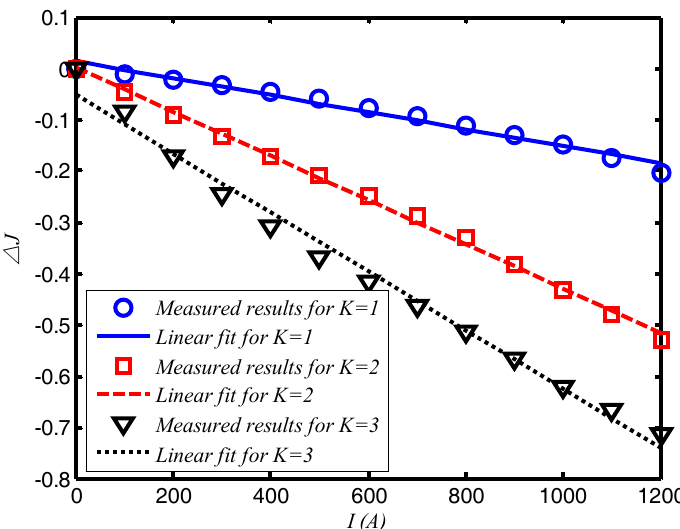
Figure 4. The relationship between current and the normalized output light difference △ J . The linear fits are based on the least squares method.